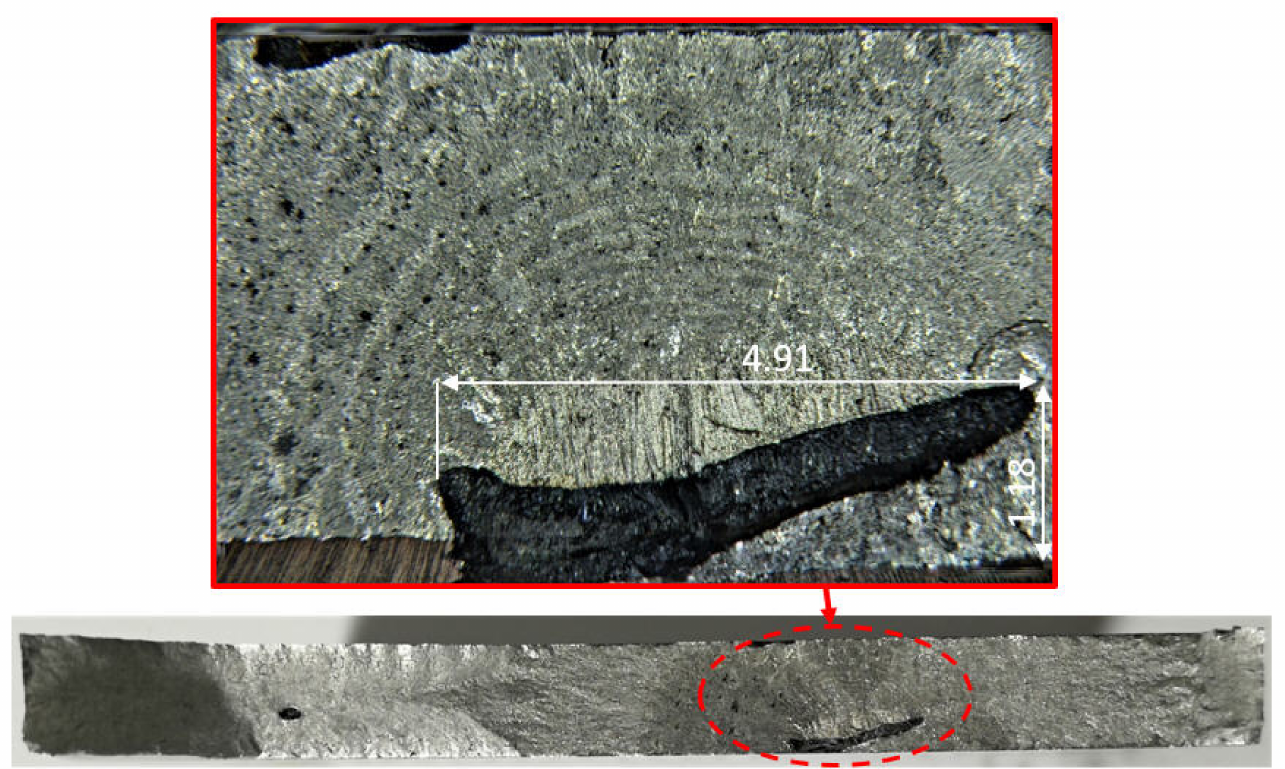
Figure 5. Expanded view of the failure